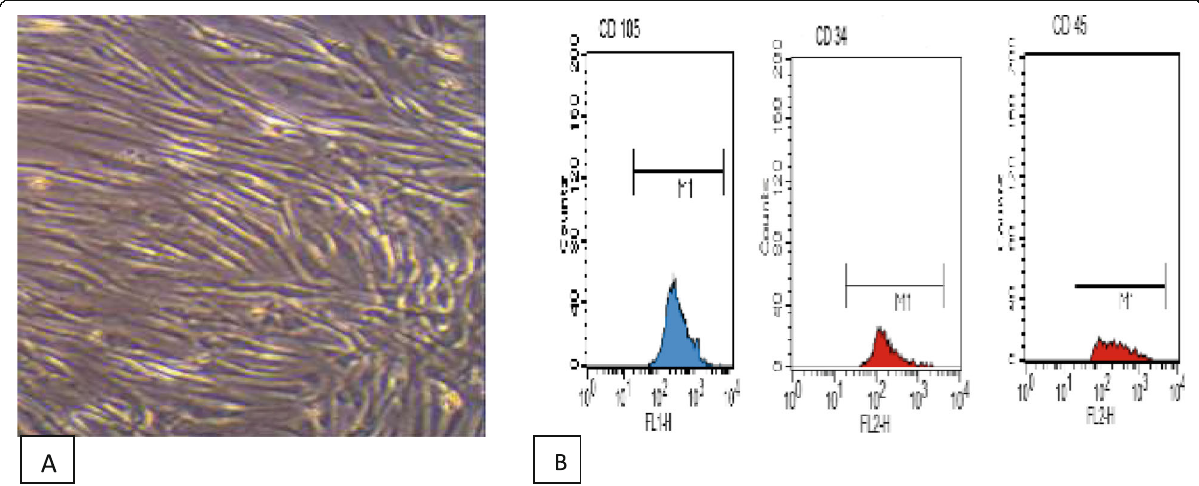
Fig. 1 a Undifferentiated spindle-shaped HBM-derived MSCs at the end of expansion phase (80% confluence, × 100). b Surface expression of the